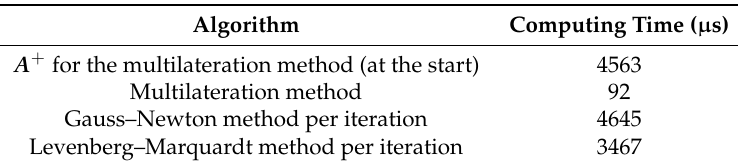
Table 8. Mean computing times of the used algorithms by MILPS. Computing times measured on an LPC2387 running at 72 MHz.